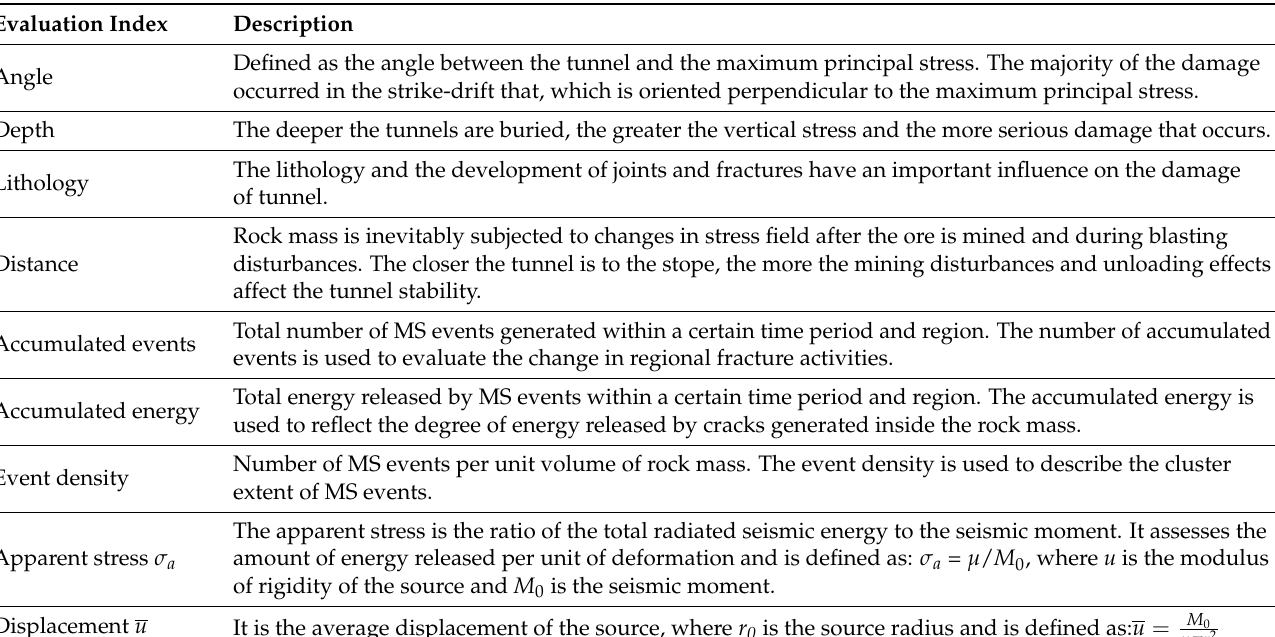
Figure 5. Distribution of MS events within the deep mining area of the Ashele Copper Mine. Table 2. Description of the evaluation indexes for tunnel failure in the Ashele copper